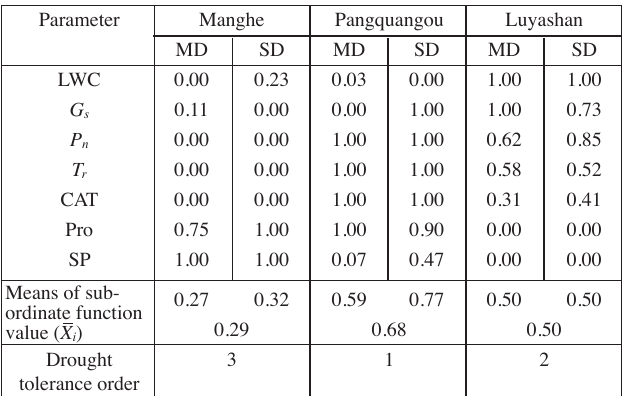
Tab. 5: Subordinate function values of drought tolerance ( X ij ) for seven selected parameters and the drought tolerance order of three pro- venances.